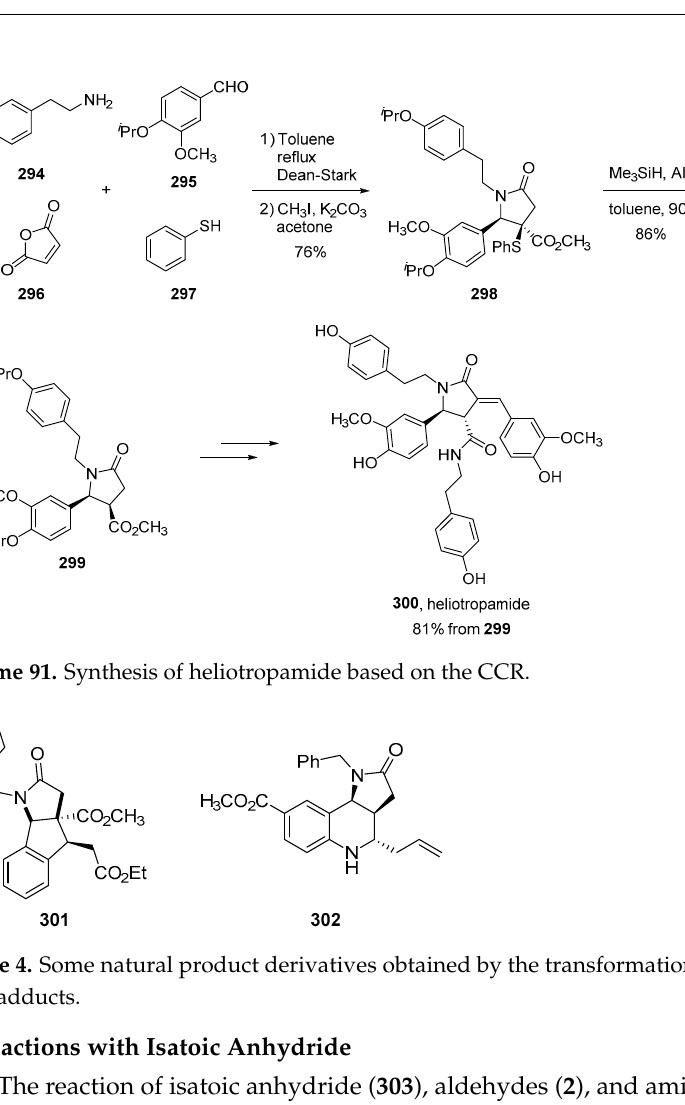
Figure 4. Some natural product derivatives obtained by the transformation of sulphur substituted CCR adducts.